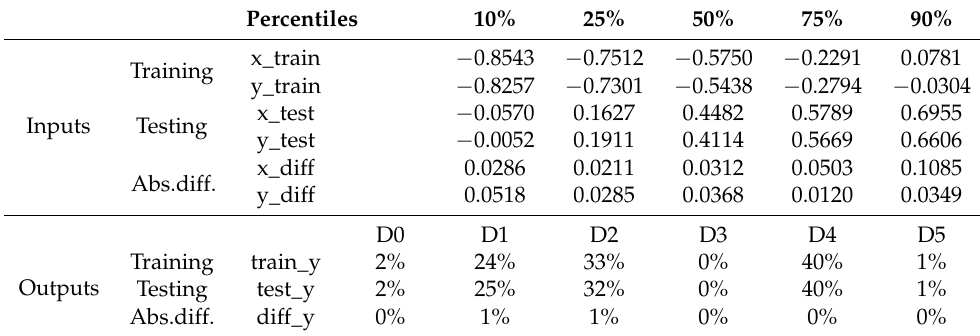
Table 5. Training and Testing dataset similarity for CEN (2D).